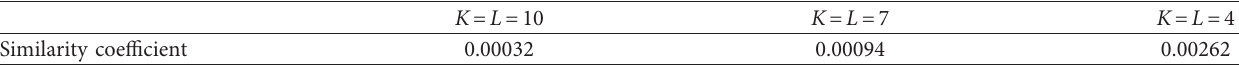
Table 5: Similarity coefficient between encrypted signal and source speech signal.